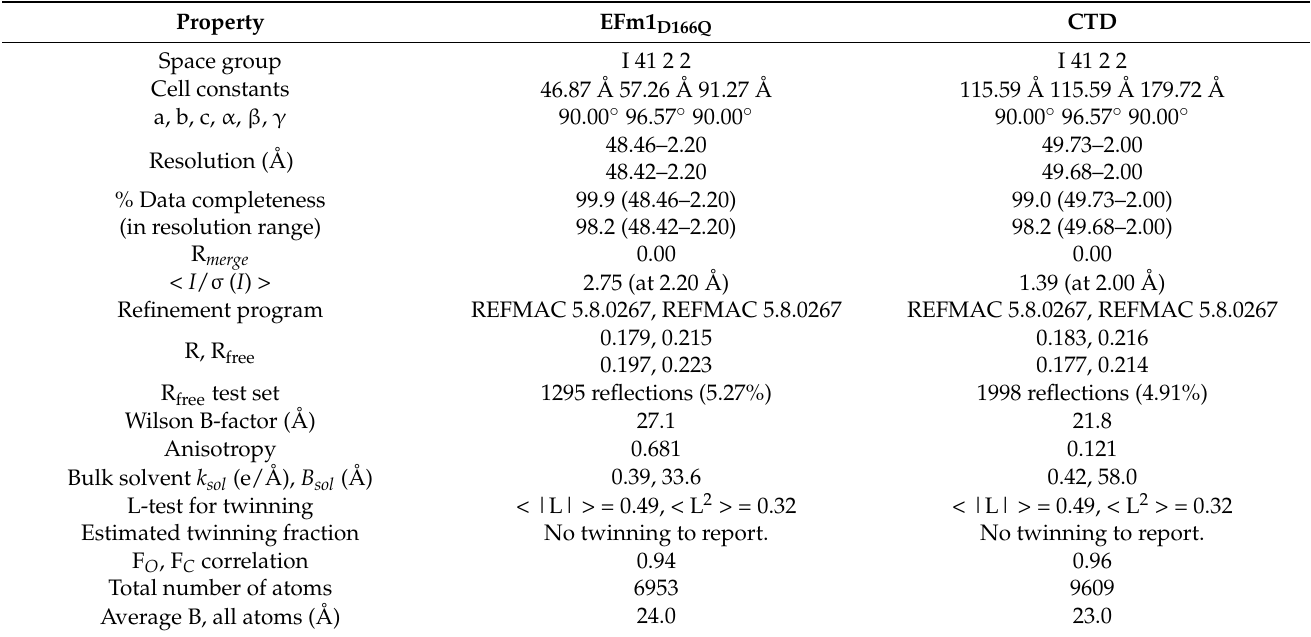
Table 2. Data and refinement statistics.